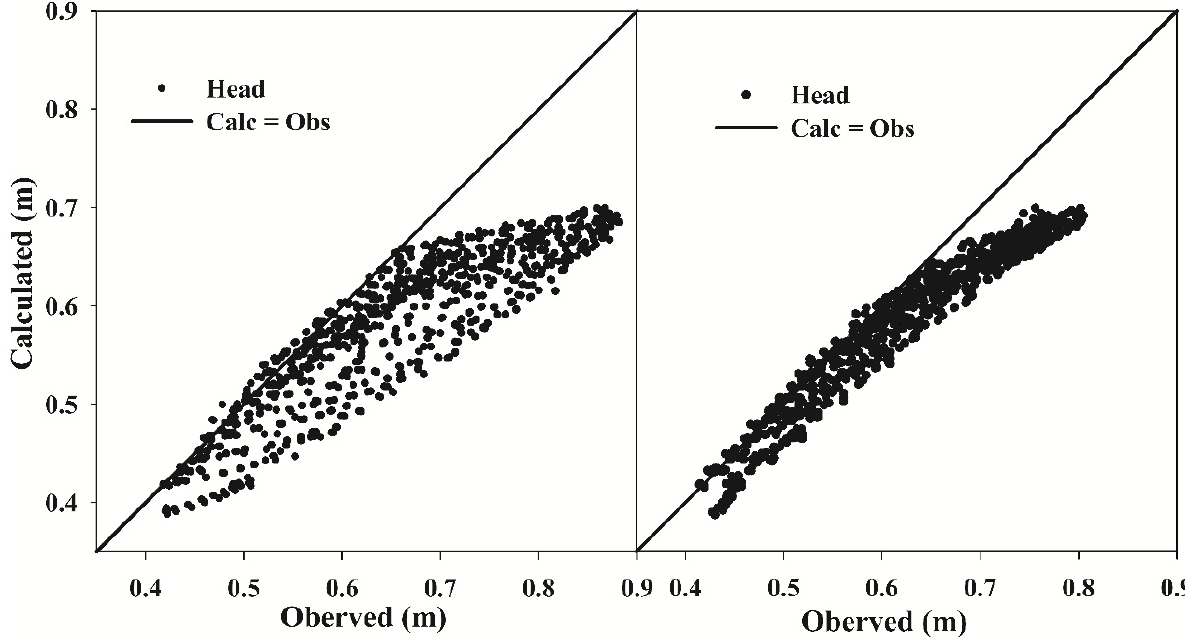
Figure 15. Time-series graphs of the groundwater level fluctuations among three scenarios during the simulated period.